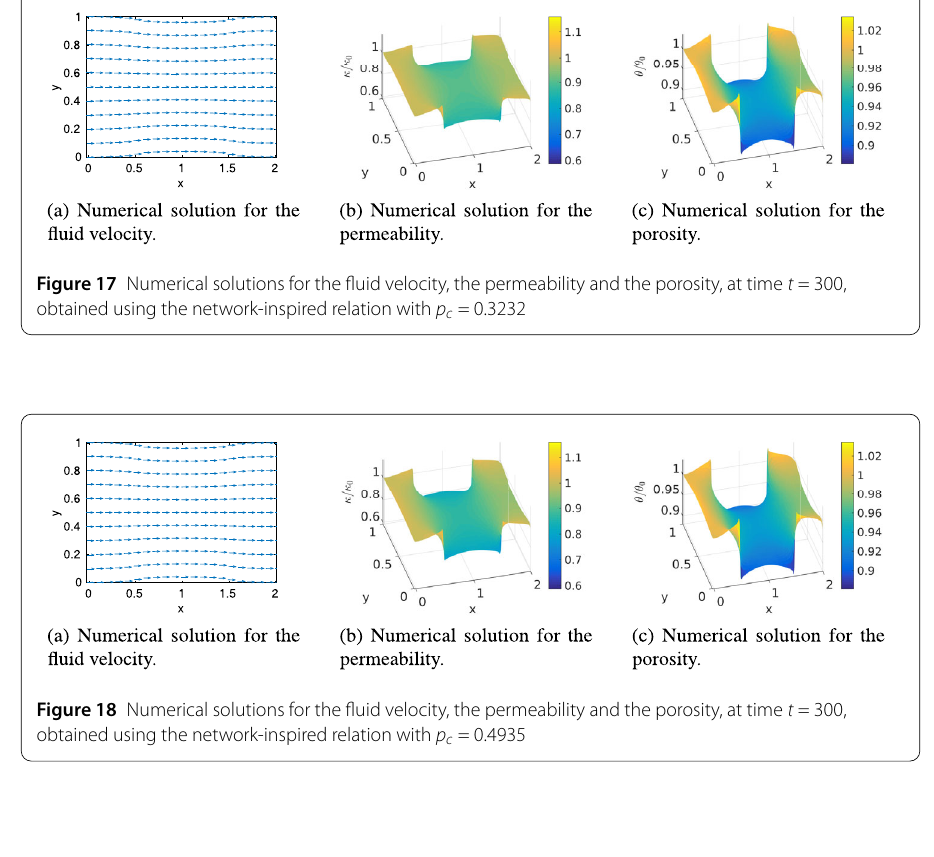
In Figs. 16(a)–18(a), the impact of the imposed vertical load on the computational do- main is shown. The magnitude of the velocity is small near the boundary segments where the vertical load is applied and large in the middle near the symmetry axis y = H /2. In the outlet, the magnitude of the velocity is maximal near the upper and lower bound- ary segments and decreases towards the symmetry axis. In all three cases, the fluid flows mainly in the horizontal direction. In the region where the load is imposed, the domain is squeezed, resulting in a larger density of the grains. This leads to a lower porosity in this region, with minimum values 0.8809, 0.8811 and 0.8810 for the Kozeny–Carman re- lation, the triangular structured network-inspired relation and the rectangular network- inspired relation respectively. The abrupt transition in the boundary condition between boundary segments Γ 1 and Γ 2 (and between Γ 4 and Γ 5 ), which results in a discontinuous force, results in a small numerical artefact at the location of these transitions. As expected from Fig. 8 and the minimum values for the porosities, the decrease in permeability by the Kozeny–Carman relation, as shown in Fig. 16(b), is larger than the decrease in the porosities obtained using the network-inspired relation, Figs. 17(b) and 18(b). In Fig. 19, the time average of the volumetric flow rate Q is depicted for different out values of the percolation threshold. Similarly to the high pump pressure problem, the flow rates for small values of the percolation threshold using the network-inspired relation are higher than the flow rates obtained using the Kozeny–Carman relation. In addition, we observe that the flow rate depends significantly on the percolation threshold and hence on the topology of the network for high percolation